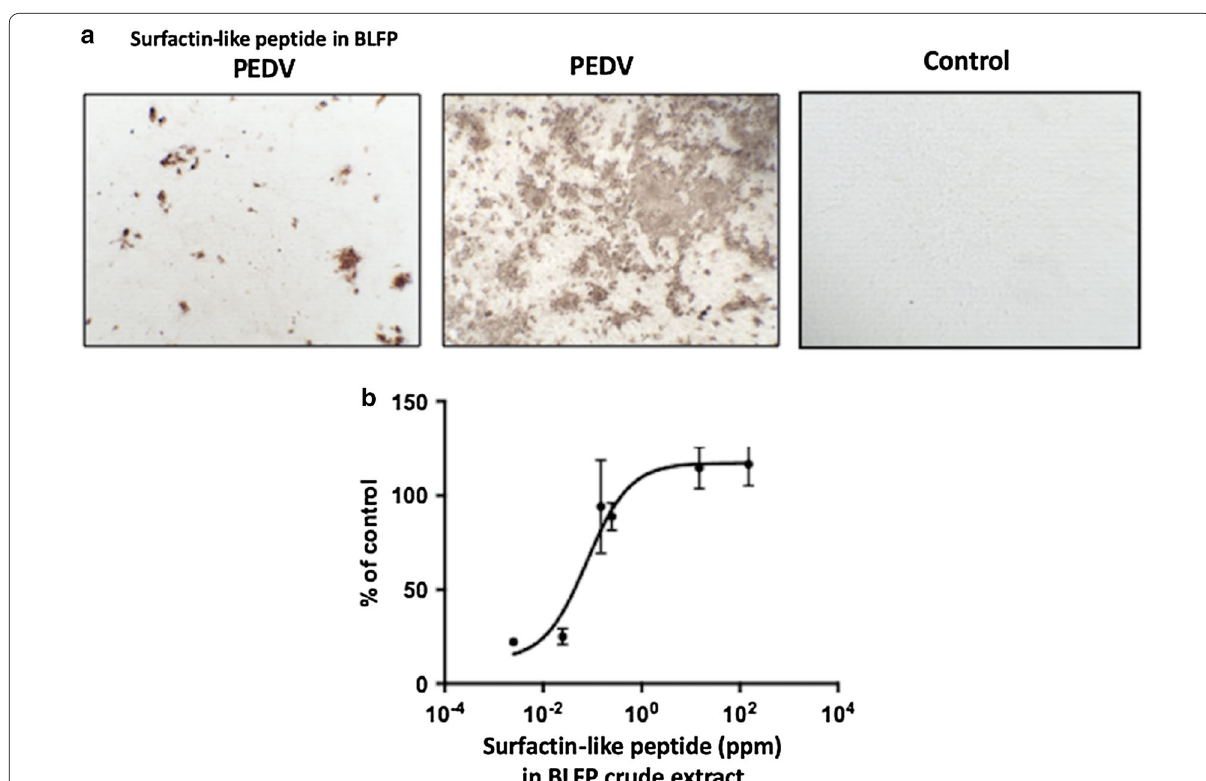
Fig. 6 Antiviral activity of crude extract derived from Bacillus licheniformis (BLFP) against PEDV infection, as well as the IC 50 , was determined using the AlamarBlue ™ assay. a PEDV‑infected Vero cells treated with (left) and without (middle) 150 ppm BLFP crude extract. The right panel shows Vero cells without any treatment. Brown coloration indicates a positive PEDV S protein signal located in the cytoplasm of PEDV‑infected cells. b Dose‑dependent effect of BLFP crude extract against PEDV. The half‑maximal inhibitory concentration (IC 50 ) of BLFP crude extract against PEDV in Vero cells is 0.07 0.45 ppm. Data are presented as the mean SD out of three test ± ±